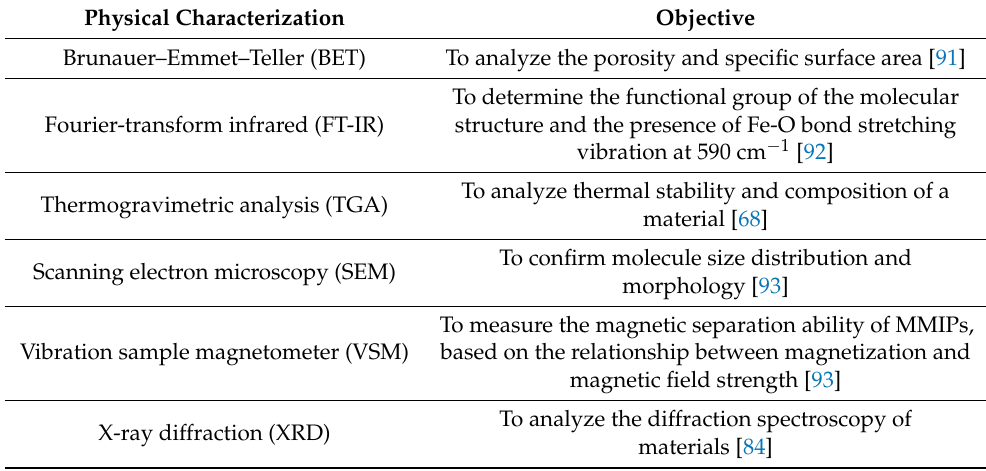
Table 3. Physical characterization of